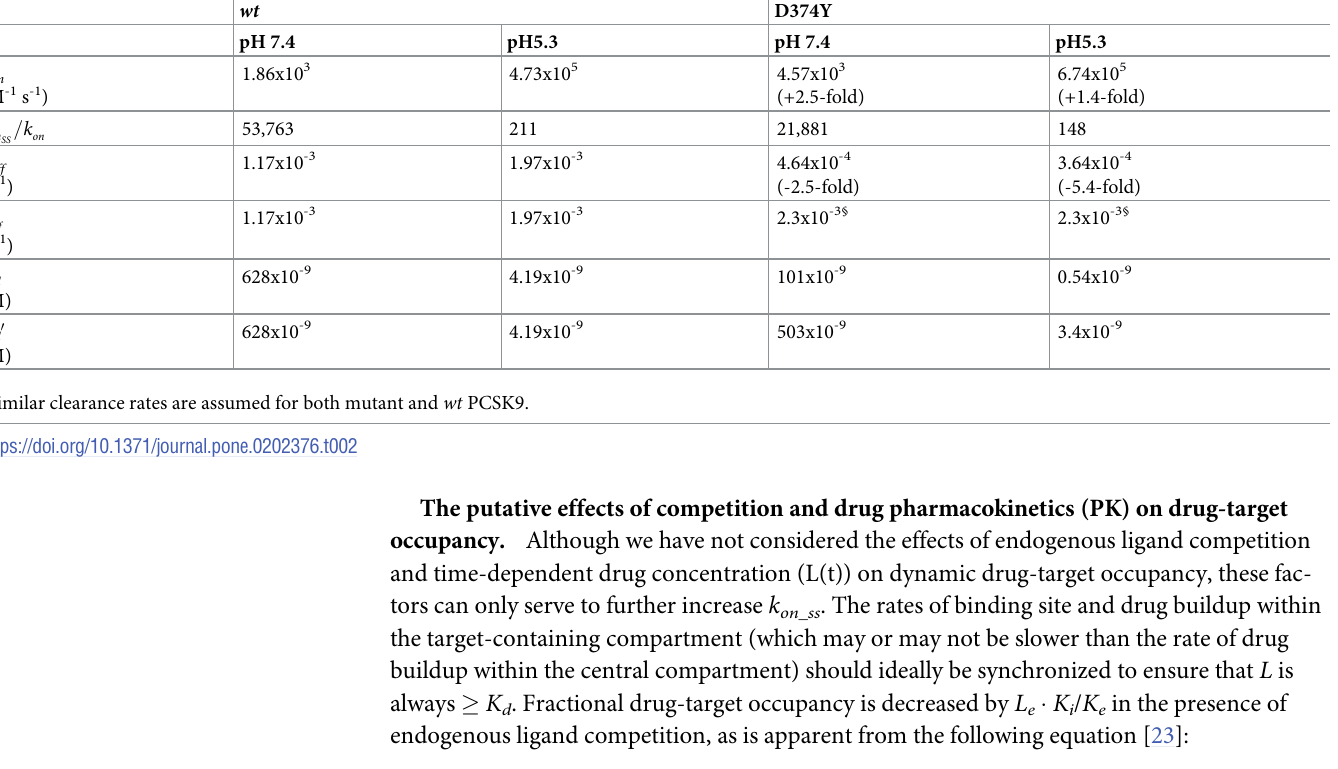
= 1x10 -2 s -1 (predicted from Eq 13 under the assumption that k i